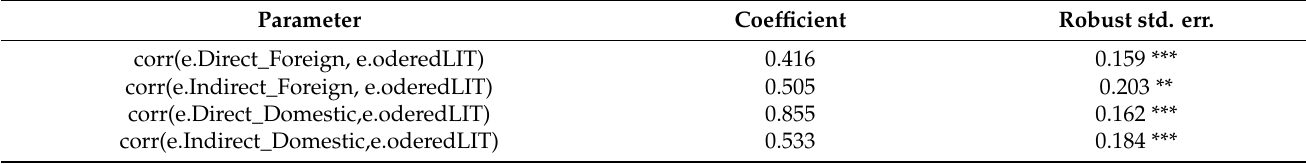
Table 6. Correlation efficient test for endogeneity of exposure to LSLA.